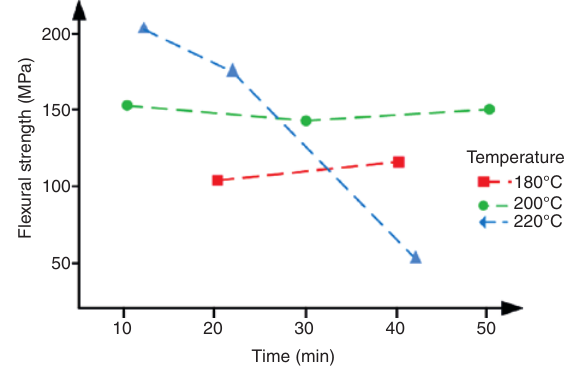
Figure 6: The interaction effects of time-temperature on the flexural strength of